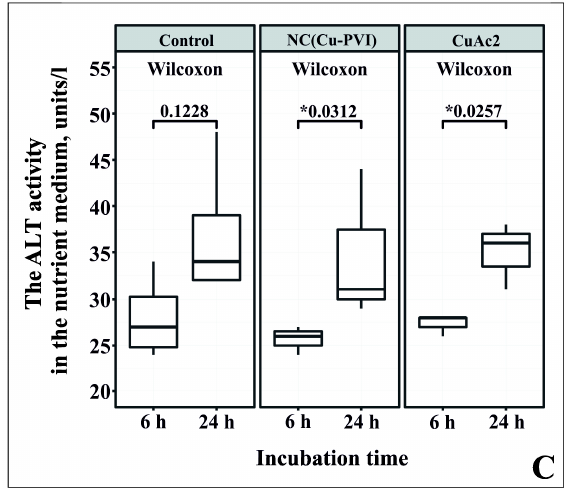
Figure 6. Change in ALT activity in the culture medium after 6 h ( A ) and 24 h ( B ) of incubation with the NC(Cu-PVI) or CuAc 2 compared with the control group and depending on the duration of incubation ( C ). Medians and first and third quartiles are shown. * Differences are considered significant at p < 0.05.